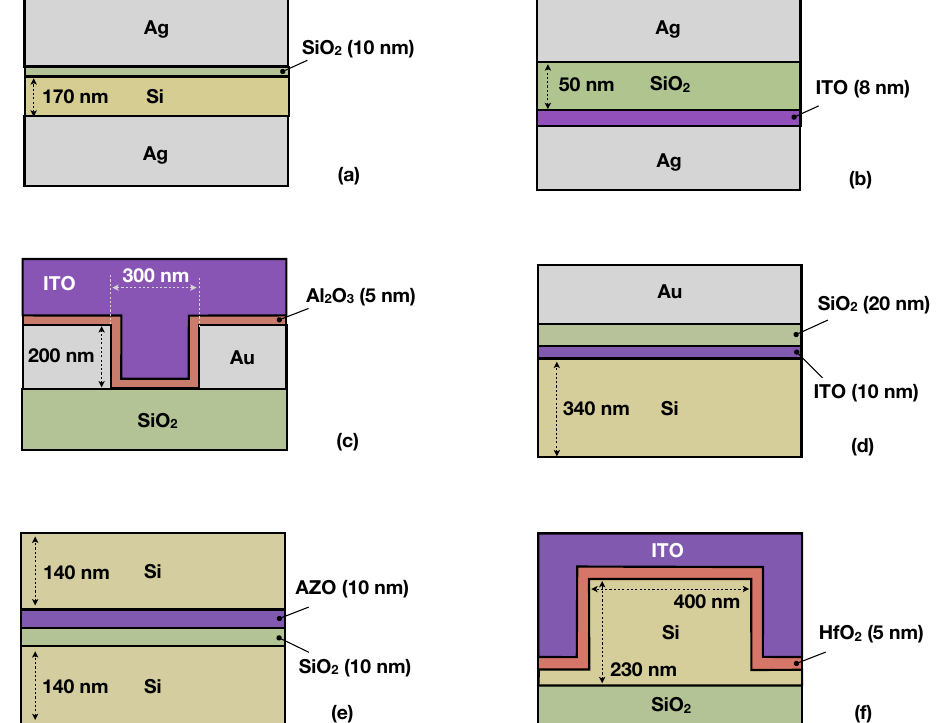
Figure 3. Various models of electro–optical modulators available in literature: ( a ) Silicon field effect plasmostor. Reprinted with permission from [64]; 2009 American Chemical Society. ( b )